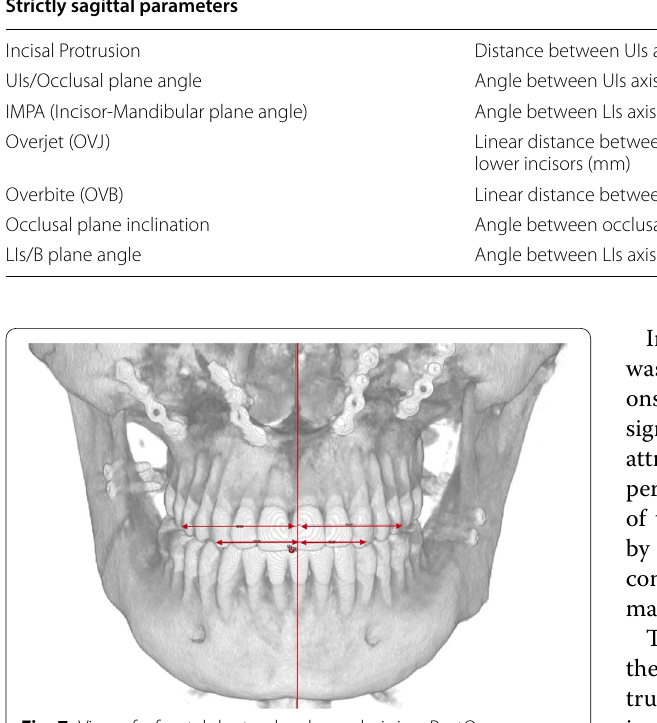
Table 7 Sagittal dento-alveolar analysis: sagittal parameters